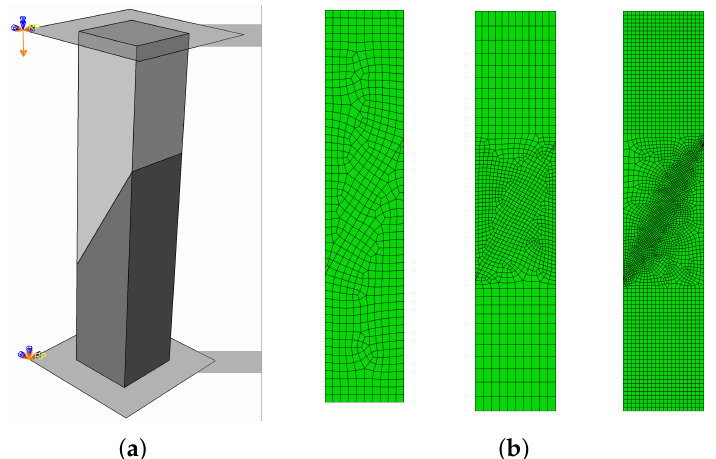
Figure 14. ( a ) Model of slant-shear test. ( b ) Meshes adopted in the analyses (respectively): 10 mm, 5 mm, and 2 mm.